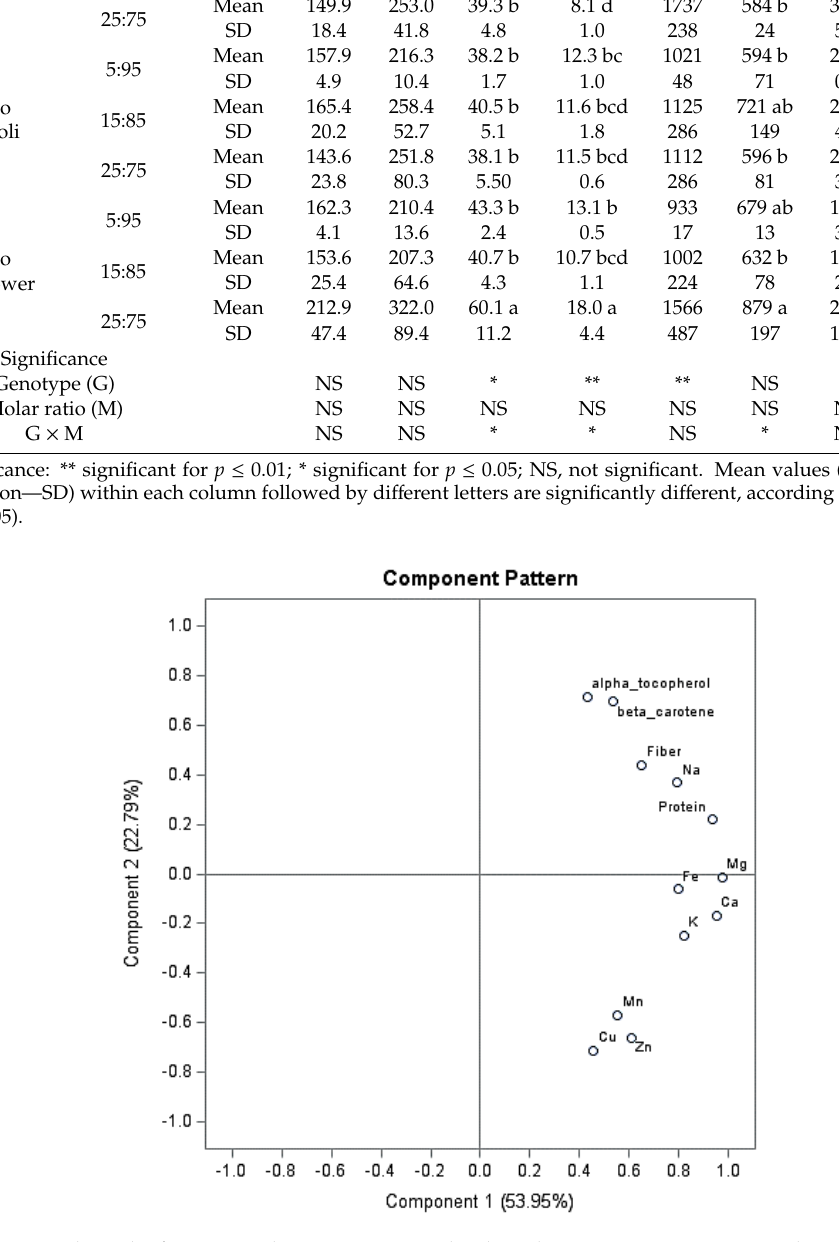
Figure2. Loadingplotforprincipalcomponents1and2, describingvariationinnutritionalparametersof Figure 2. Loading plot for principal components 1 and 2, describing variation in nutritional three Brassica genotypesofmicrogreensgrownusingthreeNH 4 :NO 3 parameters of three Brassica genotypes of microgreens grown using three NH 4 :NO 3 molar ratios in the nutrient solution.